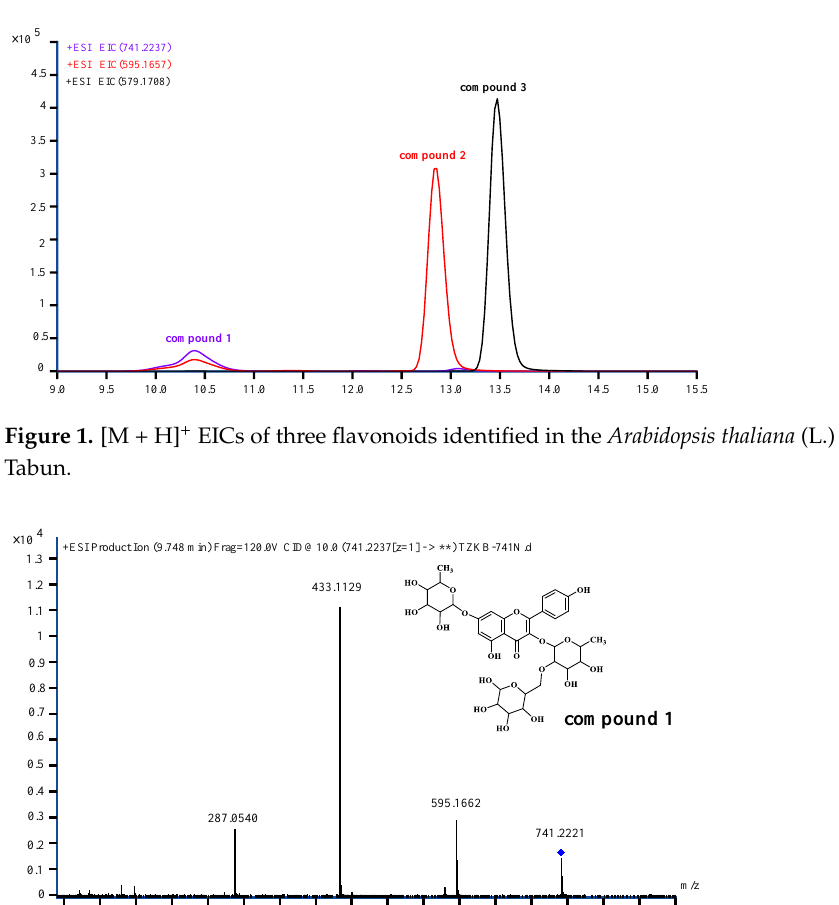
Figure 2. PIMS of kaempferol-3-O-rhamnosyl-glucoside-7-O-rhamnoside (compound 1 ). The blue sign was used to mark the precursor